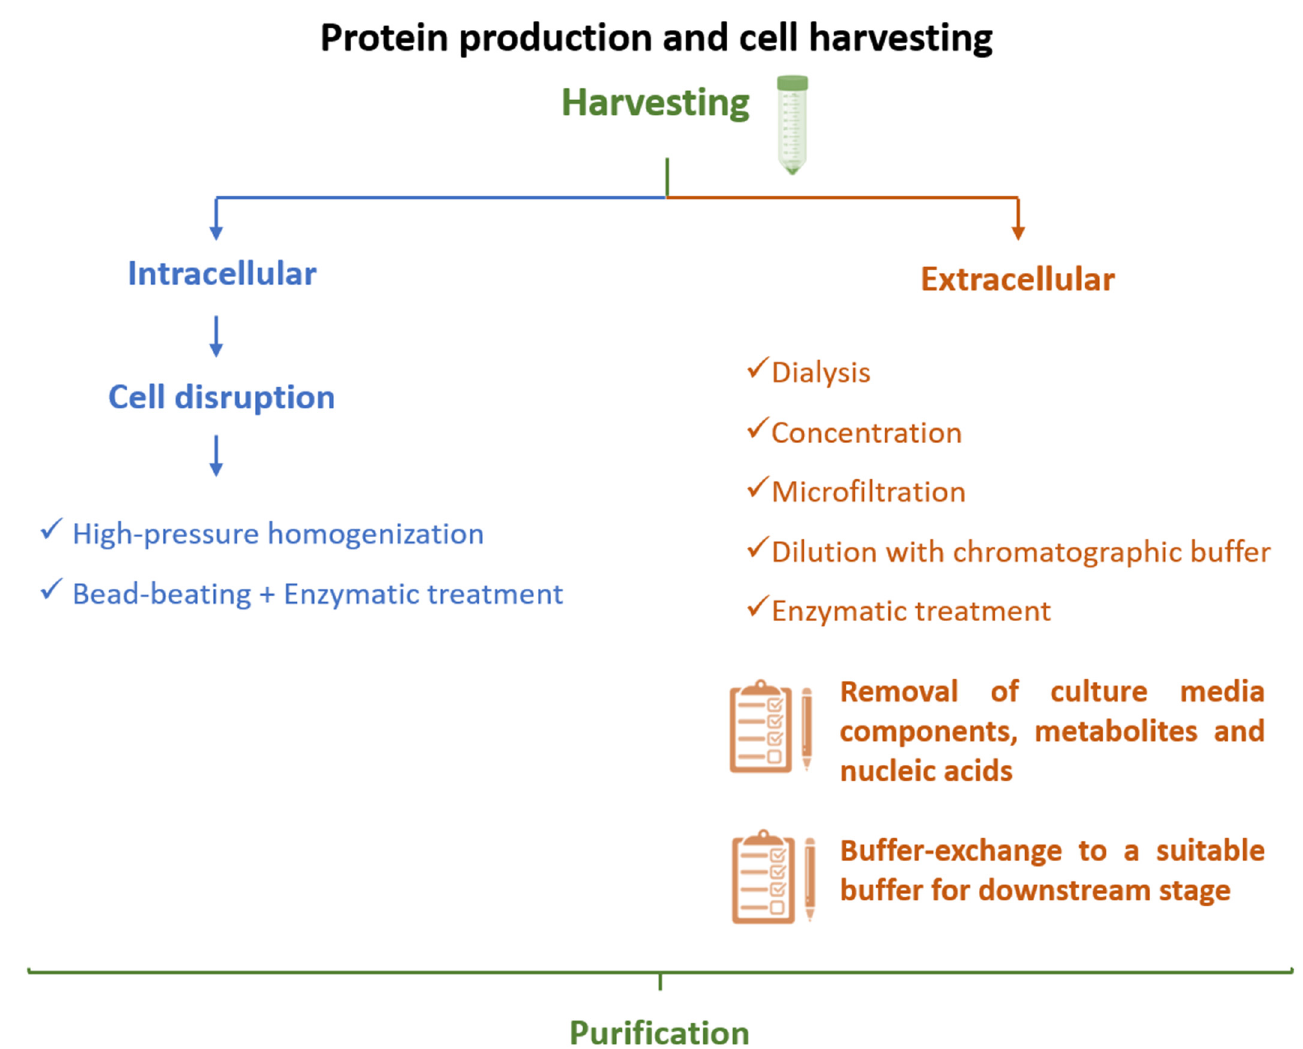
Figure 6. Primary recovery strategies for P. pastoris derived